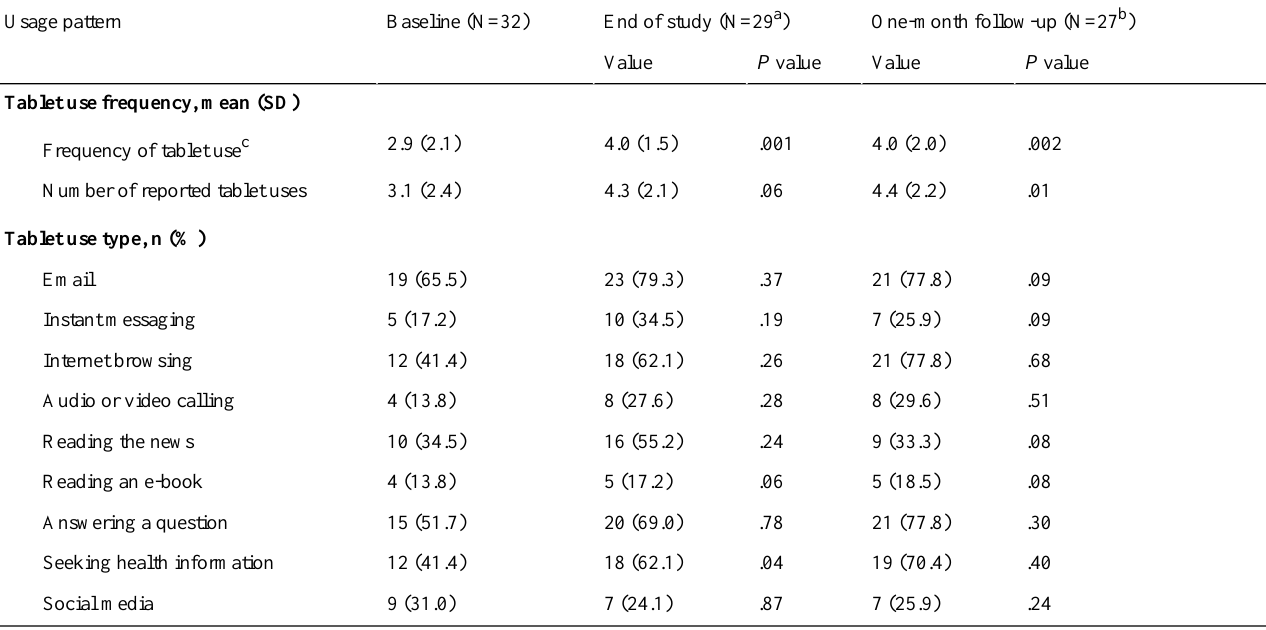
Table 3. Participant tablet usage patterns before and after the AGE-ON program.